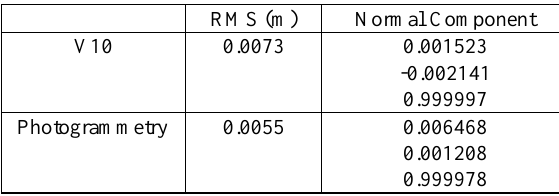
Table 2. Statistical of the floor fitting plane